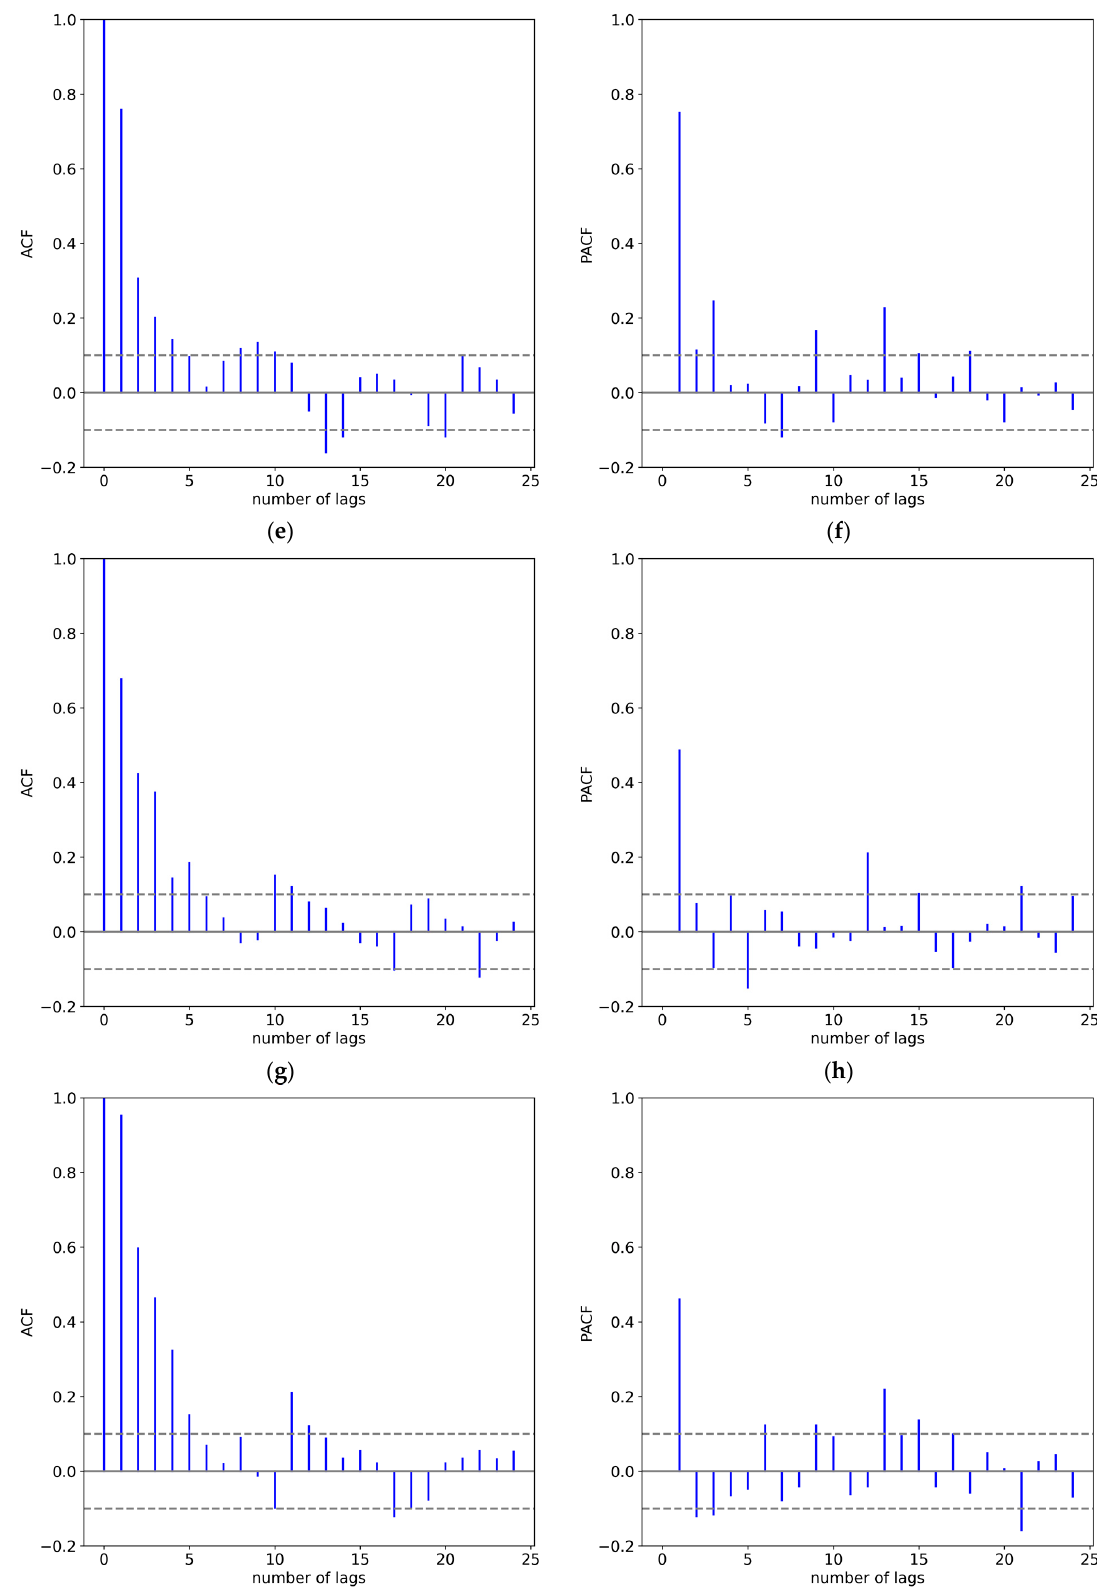
Figure 20. ACF and PACF plots of SVR ( a , b ), LSTM ( c , d ), CNN-LSTM ( e , f ), LSTM-Attention ( g , h ), BiLSTM ( i , j